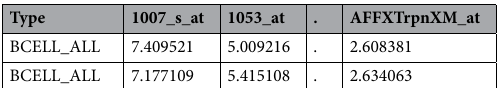
Table 6. Sample of Leukemia_GSE28497 dataset.